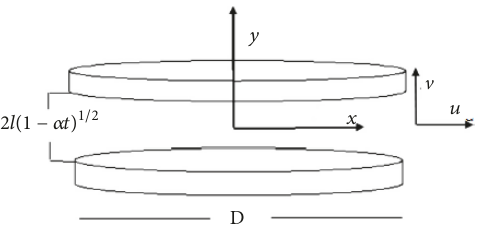
Figure 1: Schematic diagram for the flow